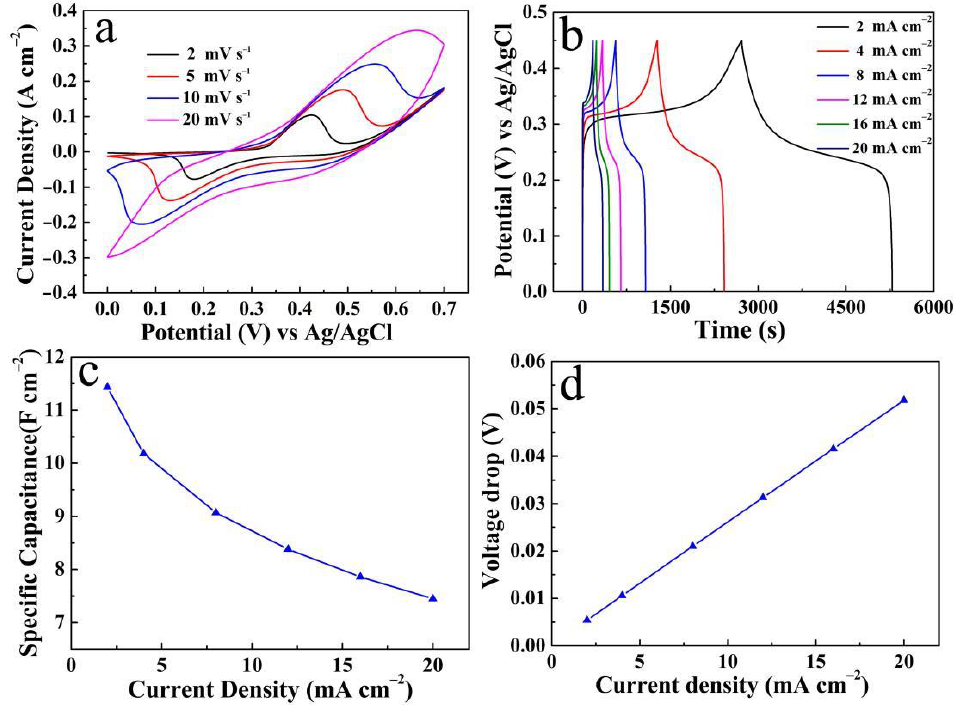
Figure 9. ( a ) CV curves, ( b ) GCD curves, ( c ) specific capacitances, and ( d ) voltage drops at different current densities of the Cu(OH) 2 /Ni 3 S 2 composite (S-20).